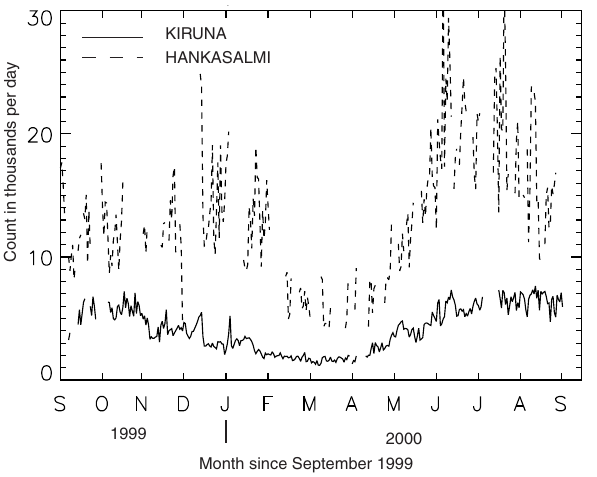
Fig. 3. Daily meteor count rates for the Hankasalmi HF radar (dashed lines) and the Kiruna VHF radar (solid lines).